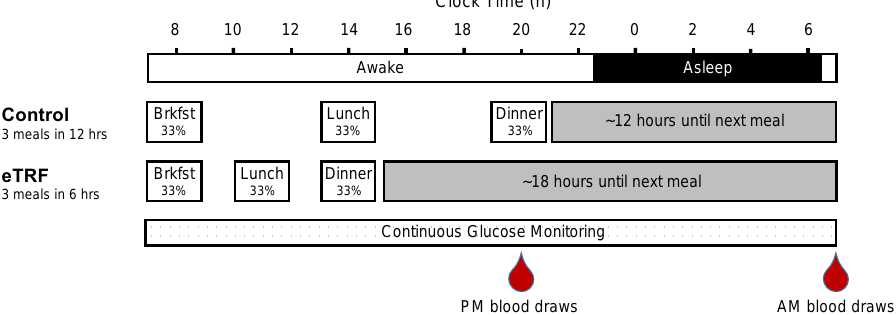
Figure 1. Study Protocol. Eleven participants were randomized to eat between 08:00 and 20:00 (control arm) or between 08:00 and 14:00 (early time-restricted feeding (eTRF) arm) for 4 days and then crossed over to the other arm after a 3.5–5-week washout period. On day 4, they consumed 3 identical meals that constituted one-third of their daily energy requirements, while undergoing 24-hour continuous glucose monitoring. In addition, blood was drawn in the evening (PM) on day 3 and in the morning (AM) on day 5 to measure serum analytes and gene